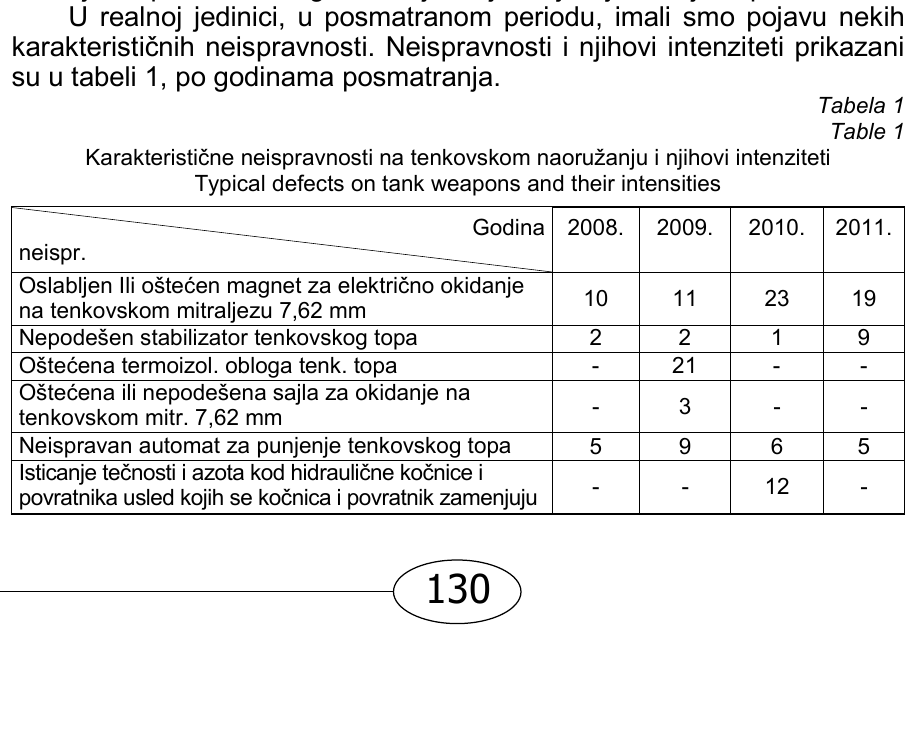
Typical defects on tank weapons and their intensities neispr.